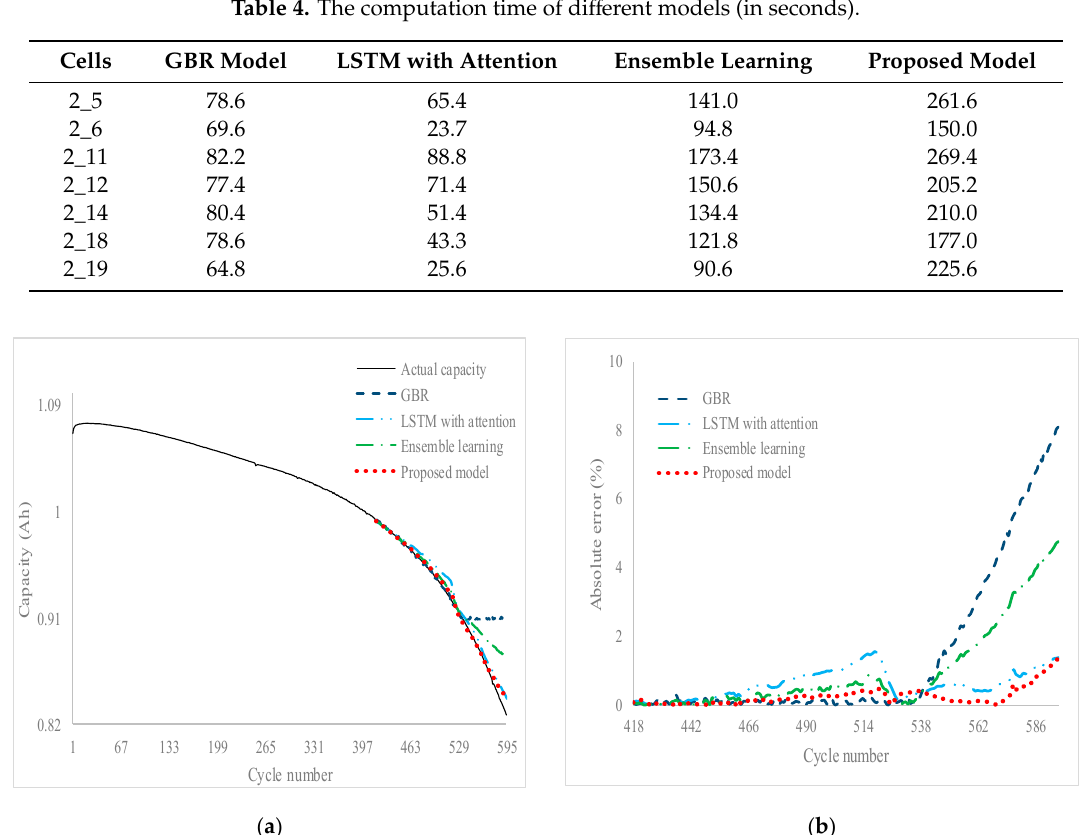
Figure 3. Prediction performance of different models on cell #2_11 cell: ( a ) prediction performance and ( b ) absolute error.